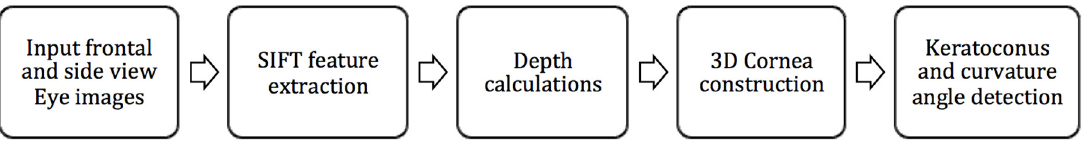
Figure 3. Block diagram of the proposed method.